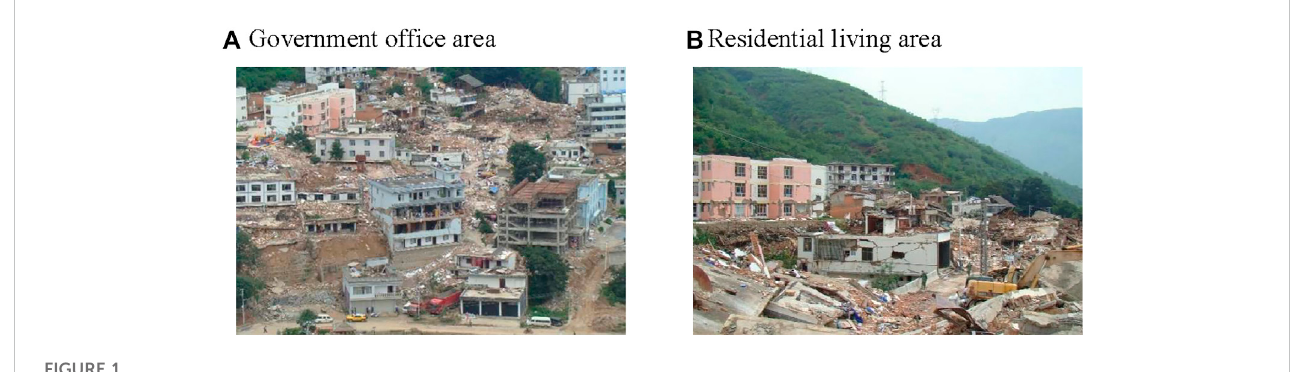
FIGURE 1 Earthquake damage in Longtoushan market